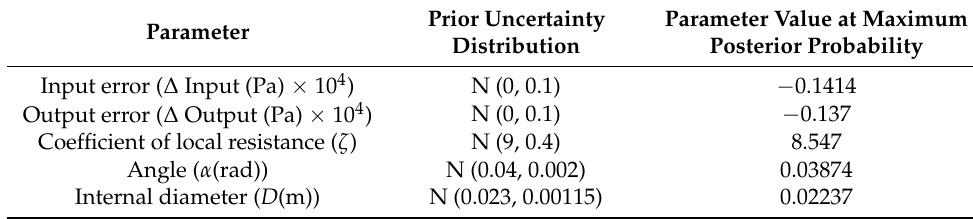
Figure 4. Posterior distribution obtained after Bayesian fusion. (“ × ” represents the parameter value when the maximum posterior probability was obtained). ( a ) Posterior distribution of input and output errors; ( b ) Posterior distribution of in-model parameters. Table 1. Updated maximum posterior distribution parameter values.